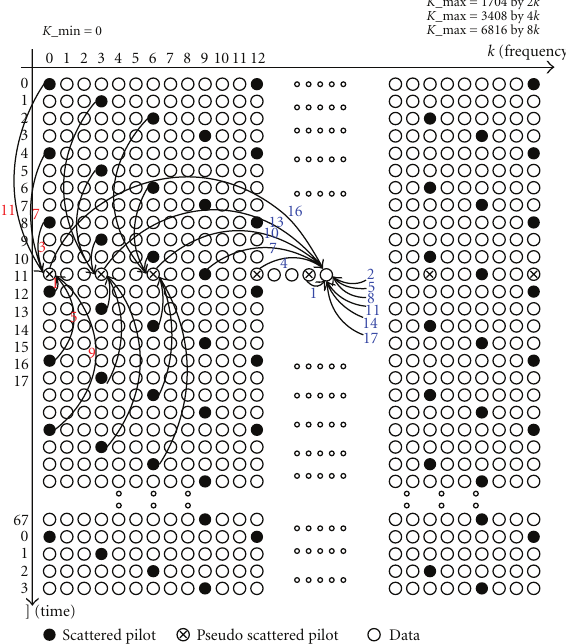
Figure 3: DVB-T/H frame structure and illustration of the channel estimation